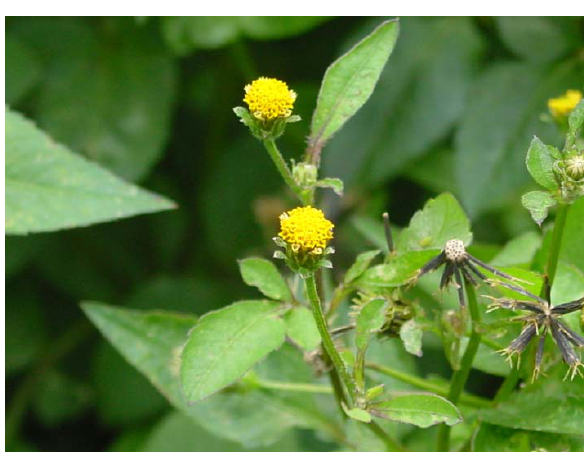
Figure 1. Bidens pilosa